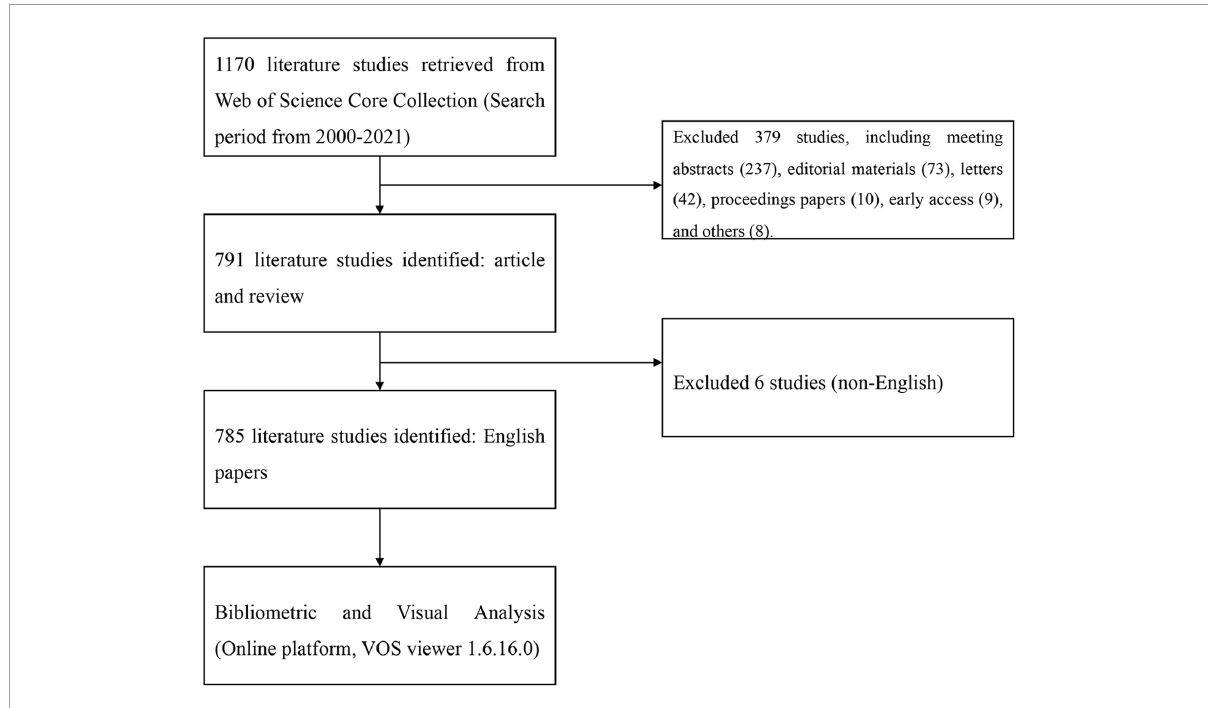
FIGURE1 Flowchart of the inclusion and exclusion criteria.